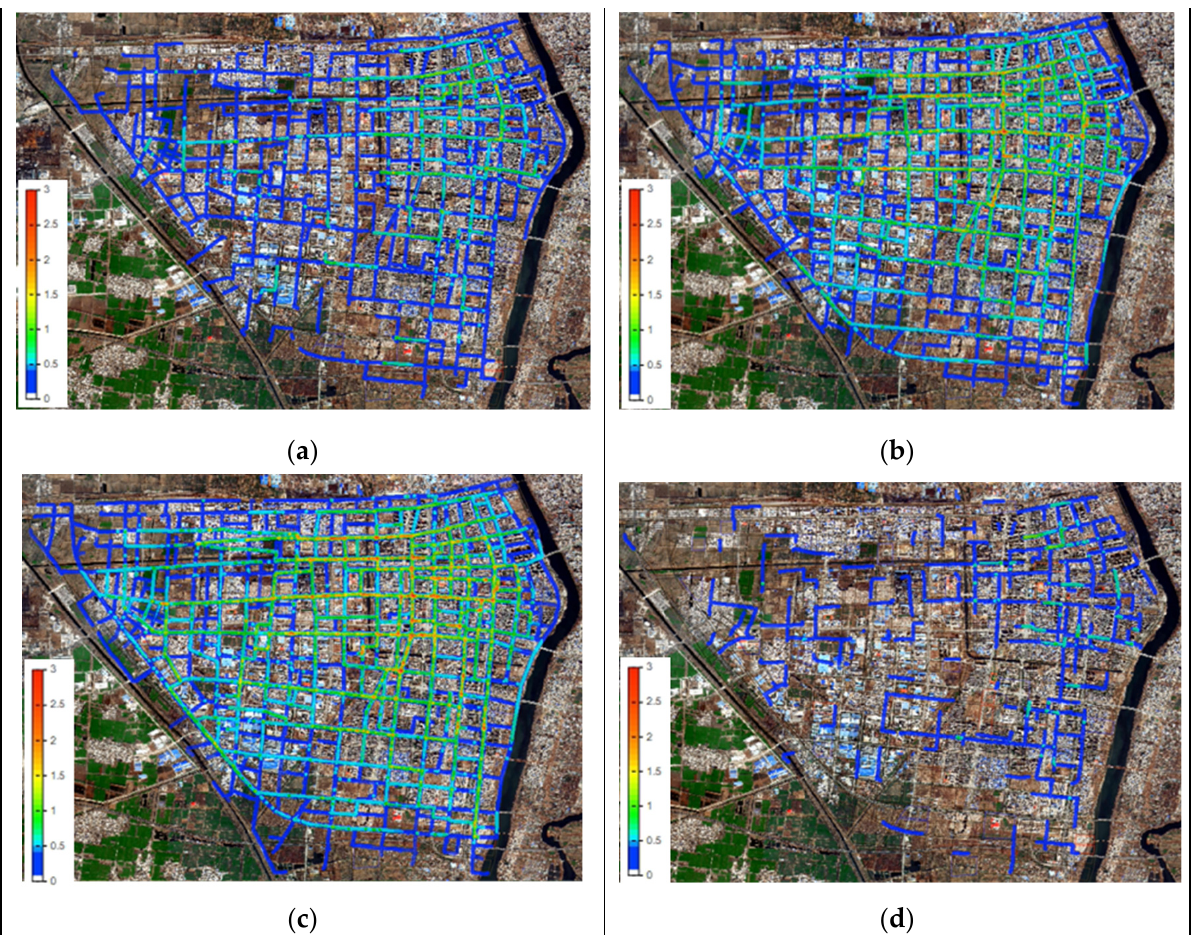
Figure 8. The evacuation model of the study area. ( a ) 5 min, ( b ) 10 min, ( c ) 15 min, and ( d ) 25 min.